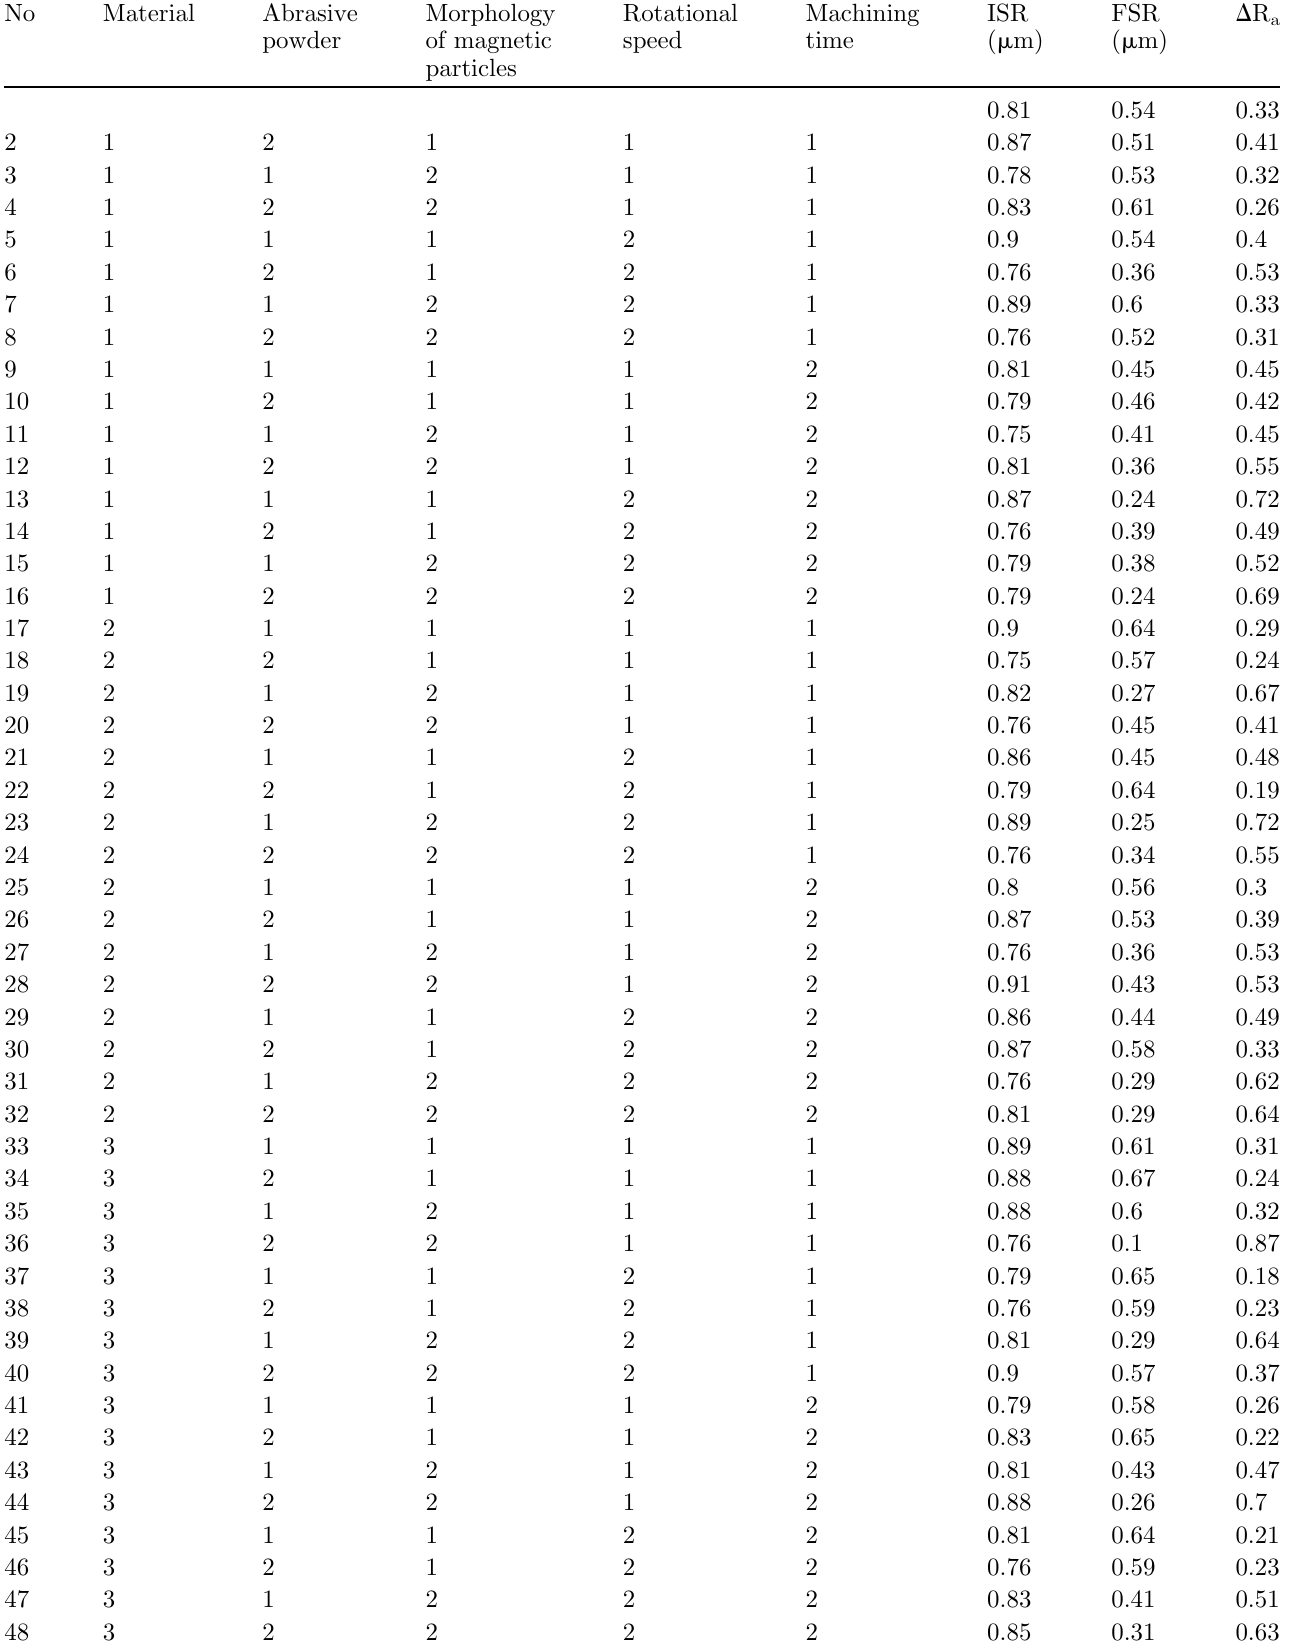
Table 3. Experimental design and